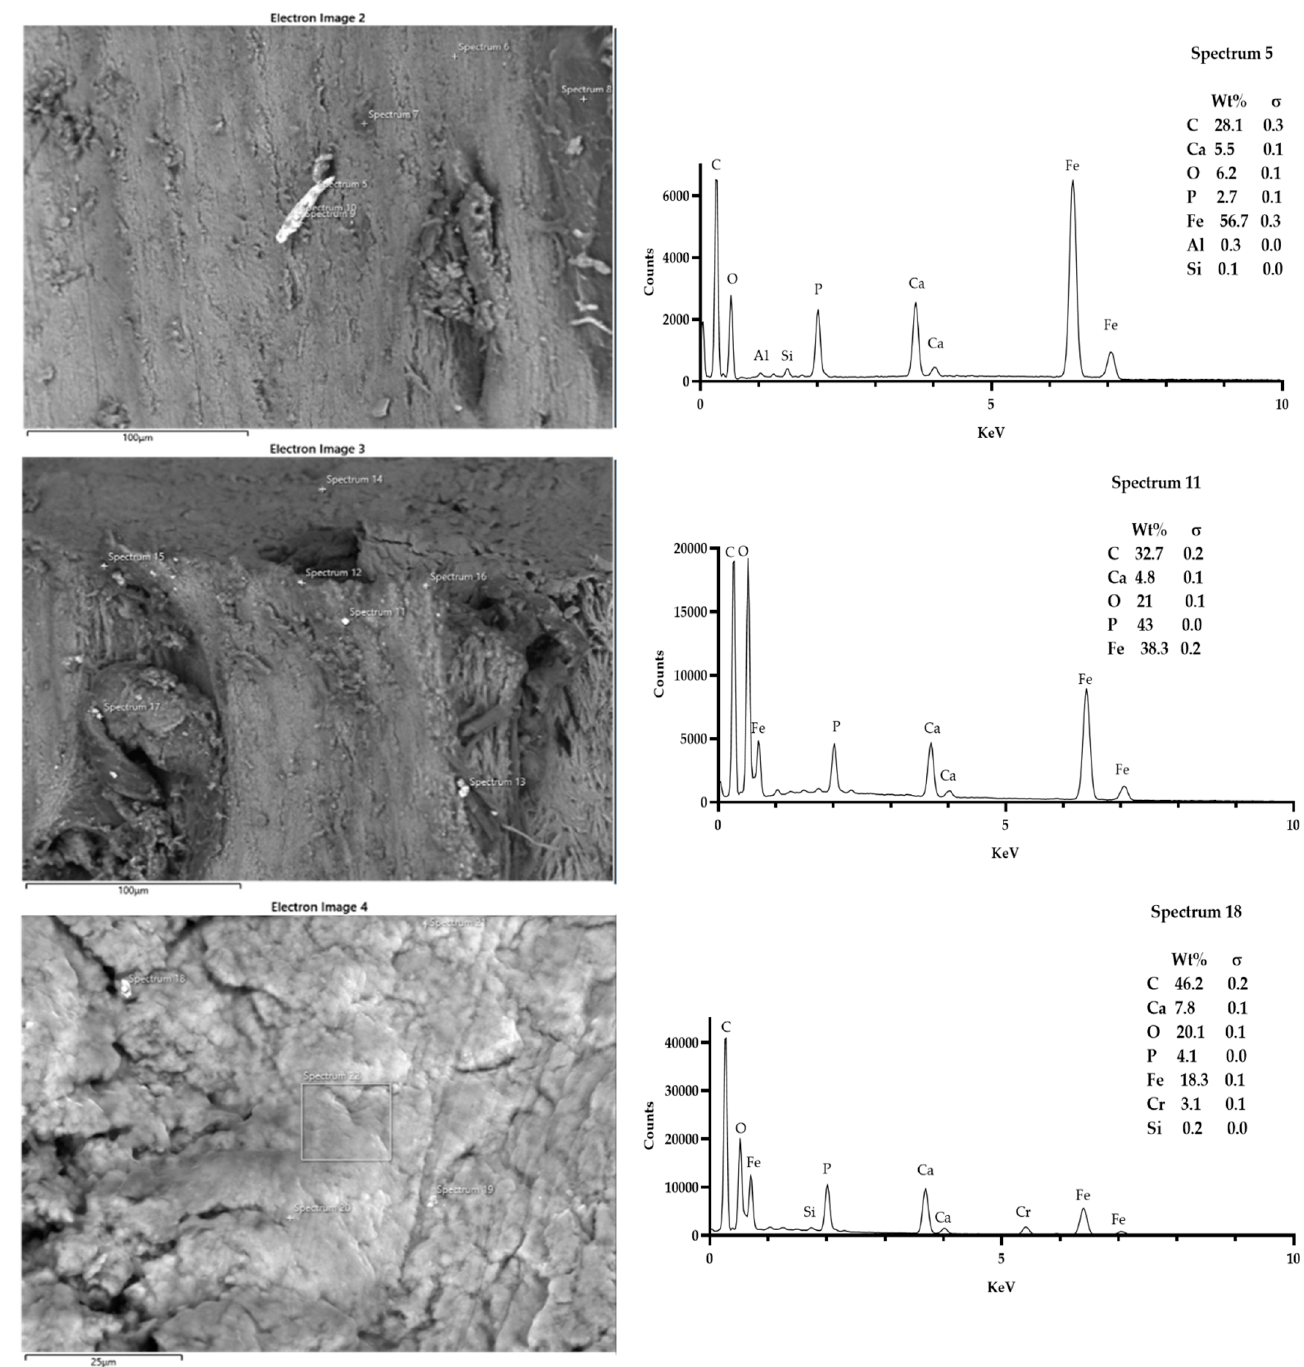
Figure 8. Sample T5. It was possible to spot up to three fields, showing the presence of particles that were morphologically reactive. The microanalysis showed the presence of iron, aluminum, siliceous, and chrome. Spectra outputs were realized using GrapPad Prism 9.3.1.